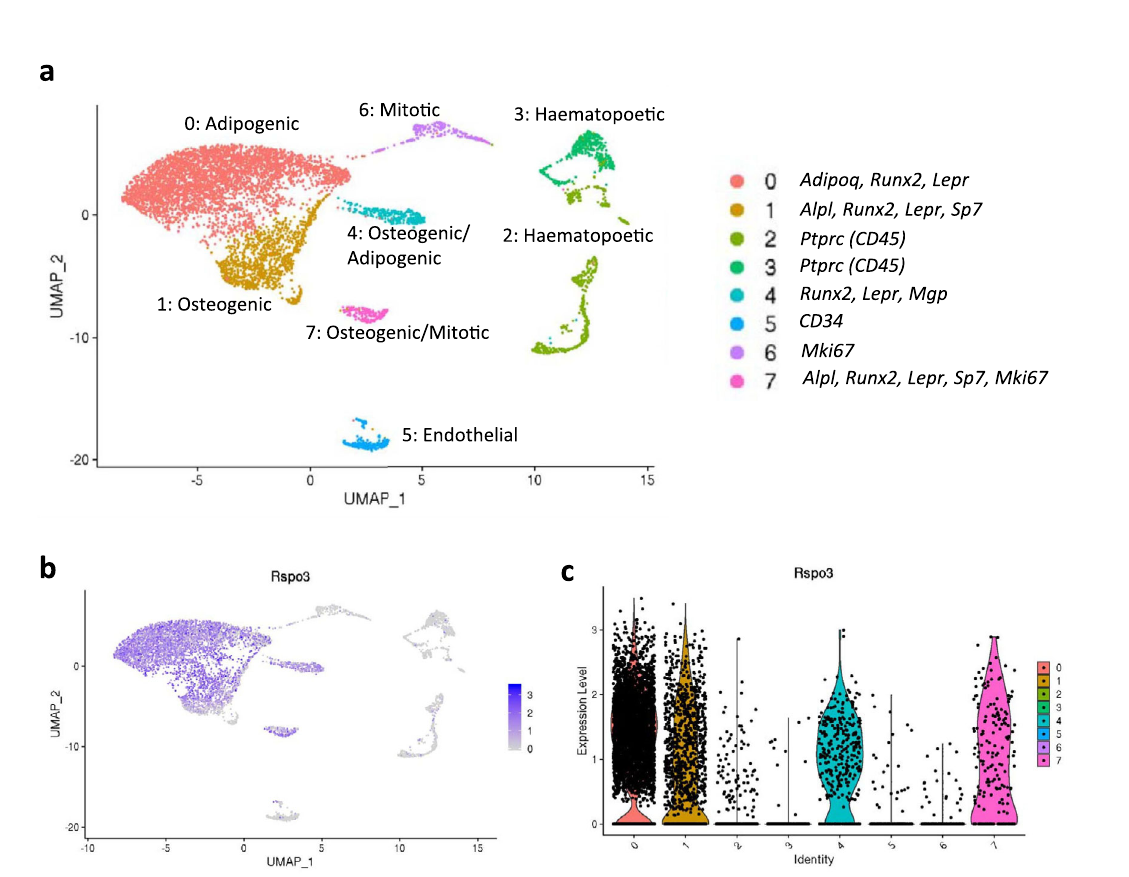
Fig. 2 Rspo3 expression in Cxcl12- expressing bone marrow stromal cells. Single cell RNA sequencing analysis of Cxcl12 expressing bone marrow cells. a Uniform Manifold Approximation and Projection (UMAP)-based visualization of major cell clusters (Cluster 0 – 7) and cluster expressed genes (right). Feature plot ( b ) and violin plot ( c ) of Rspo3 and tibial cortical diaphyseal bone with no reduction in brain cortex or liver compared to Rspo3 fl ox/ fl ox mice (Fig. 3b). Thus, osteoblast-derived RSPO3 is the principal source of RSPO3 in both trabecular and cortical bones. Runx2-creRspo3 fl ox/ fl ox mice were born apparently healthy and had a normal body weight growth at termination at 12 weeks of age and displayed normal weights of several visceral organs (Fig. 3c, d). Consistent with the human genetic fi ndings, CT analyses revealed reduced trabecular bone mass re fl ected by reduced trabecular bone volume fraction (BV/TV; Fig. 3e, f), trabecular thickness (Fig. 3g), trabecular number (Fig. 3h) and increased trabecular separation (Fig. 3i) in the lumbar vertebra L5 of Runx2-creRspo3 fl ox/ fl ox in both female and male mice compared to Rspo3 fl ox/ fl ox mice. Reduced